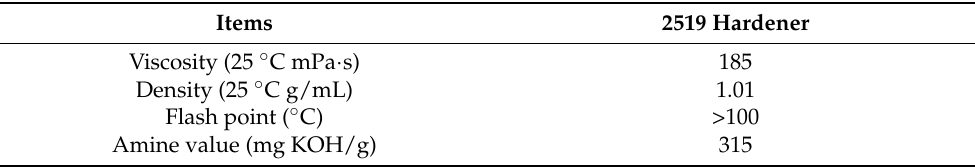
Table 3. The main physical and chemical properties of 2519